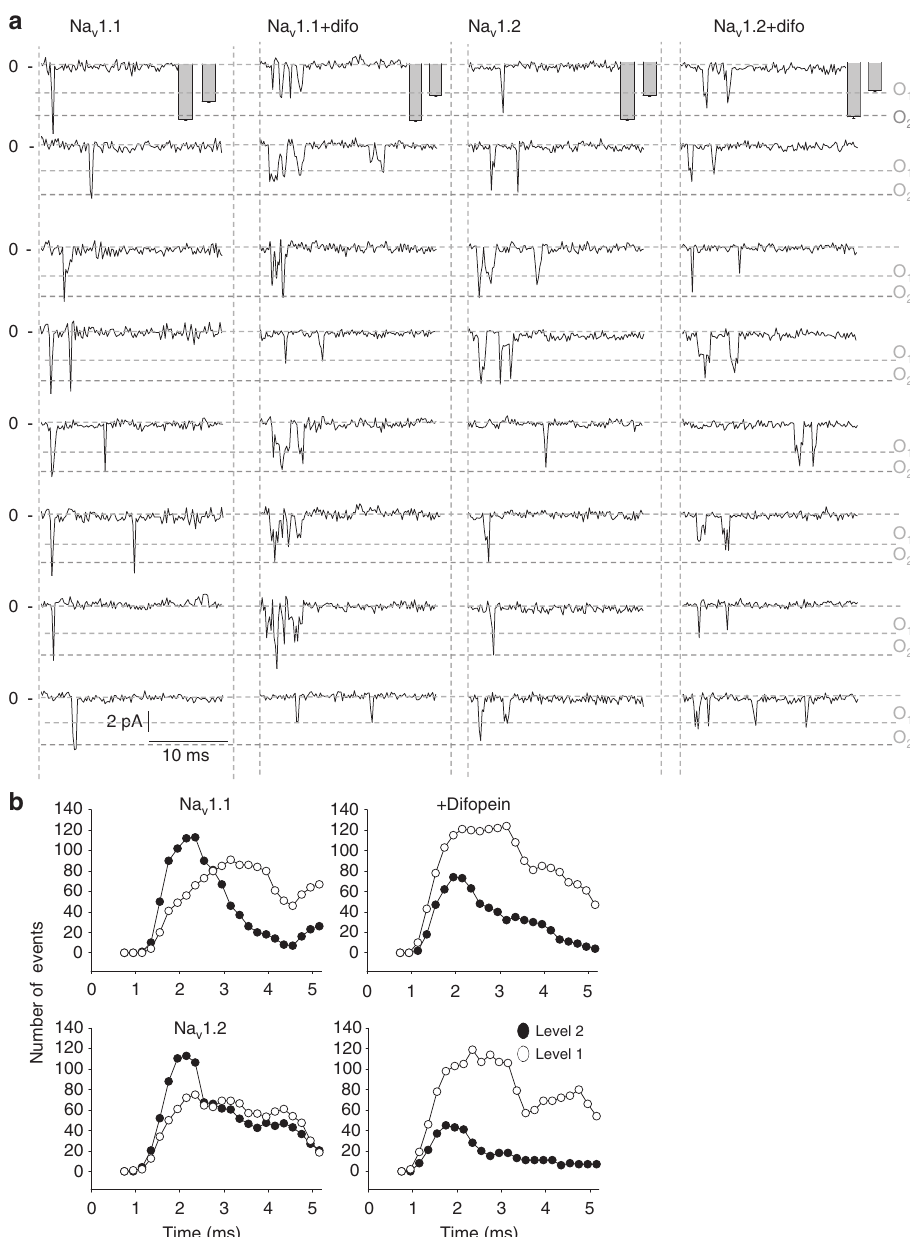
Fig. 9 Neuronal sodium channel, Na v 1.1 and Na v 1.2 also display coupling at the single-channel level mediated through 14-3-3. a Representative traces of single-channel recordings at − 40 mV for Na v 1.1 and Na v 1.2 expressed in HEK293 cells with or without difopein. The overall amplitudes for single and double openings are represented as mean ± SEM in the gray bars. The dotted lines correspond to single-level openings (O 1 ) and double-level openings (O 2 ), respectively. The number of channels under a patch was estimated by the amplitude and detected by the Clamp fi t analysis software. b Number of openings at the single or double level in function of time. 400 hundred sweeps were recorded by depolarizing the membrane to − 40 mV. The number of openings at level 1 (single or uncoupled dimer) or openings of level 2 (coupled dimer) were plotted in function of key role on the evolution of excitable tissues 24,25 and their involvement in a whole host of diseases from cardiac arrhythmias to epilepsy, myotonia, paralysis, erythromelalgia, and ataxia, our results have tremendous implications allowing us to explain the mechanisms behind unexpected phenotypes in sodium channelopathies 32,33 . Supplementary Table 2.